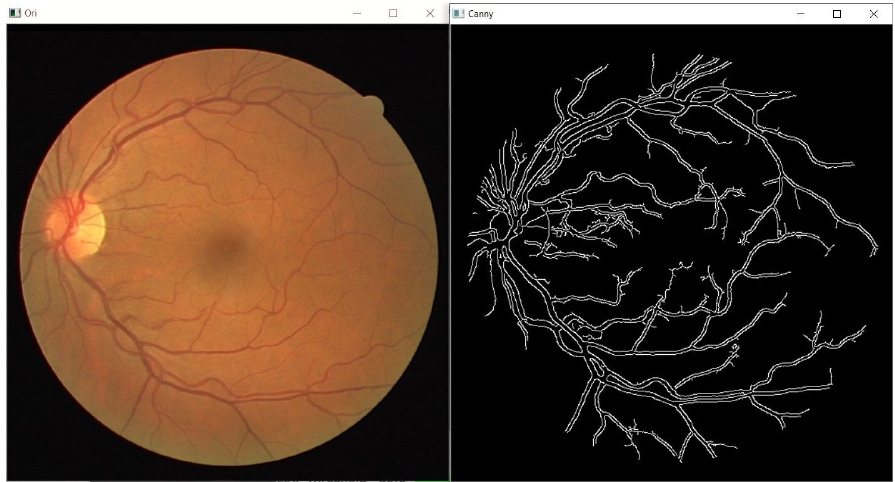
Figure 4. Image of input retinal fundus image and its image after edge detection is applied.